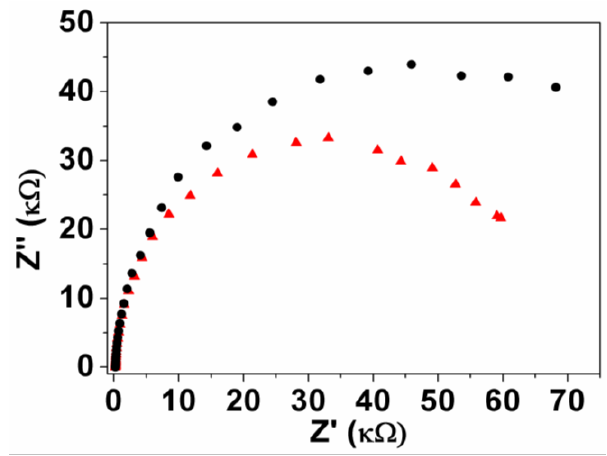
Figure 4. Nyquist plot registered for the CNTME (activated and inactivated) in 1.0 × 10 −6 mol·L −1 of AG25, 0.04 mol·L −1 B-R buffer solution, pH =